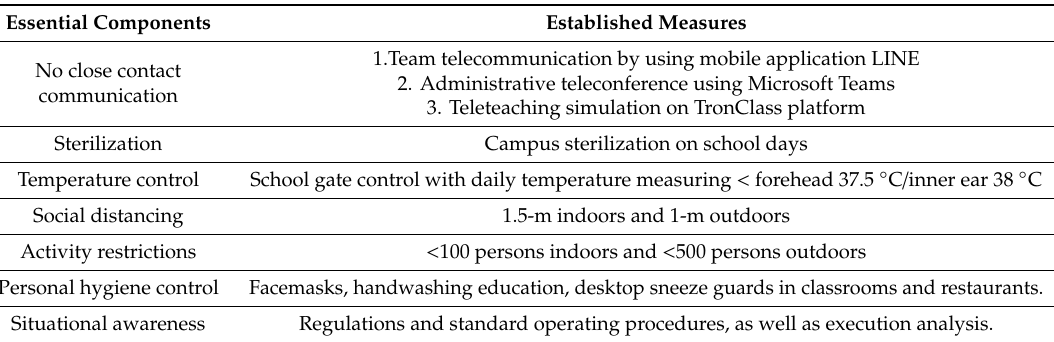
Table 1. Essential components in established measures.